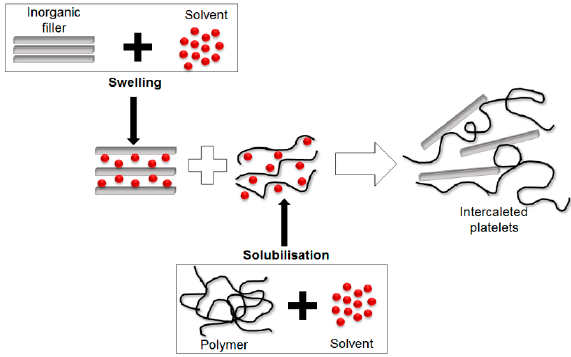
Figure 18. Schematic representation of the solution processing (Redraw and adapted figure from [93]).